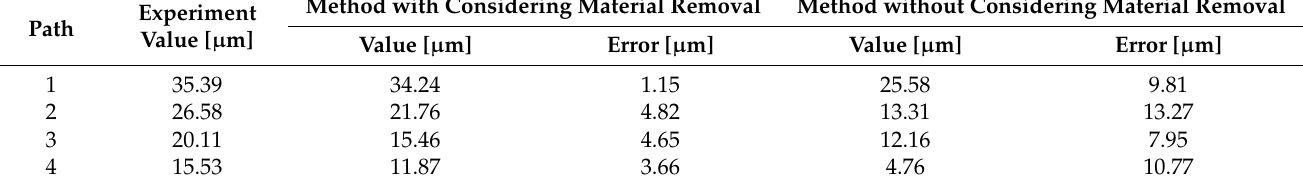
Figure 14. Surface location error comparison between measurement and proposed and compared methods.